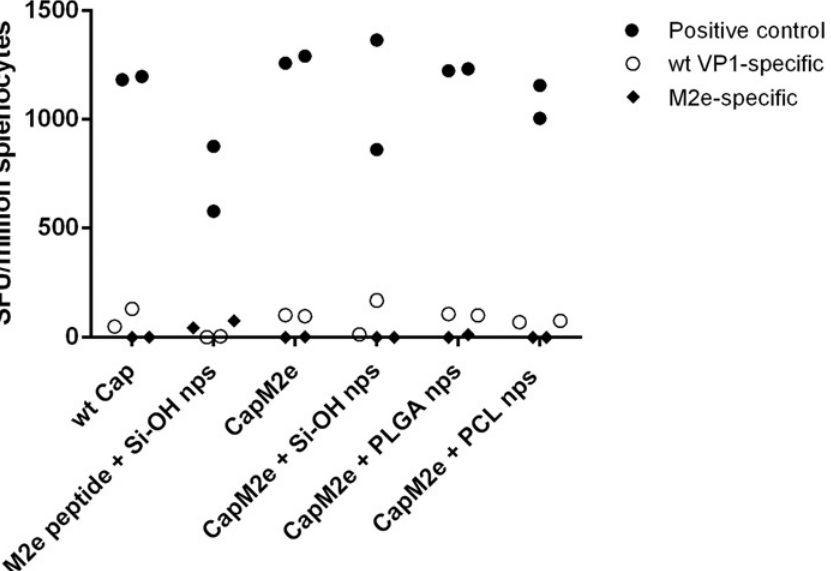
Fig 4. Determination of IFN γ response in splenocytes. M2e-specific T-cell response was evaluated by measuring IFN γ secreting cells by enzyme-linked immunospot (ELISPOT). A) Carrier (wt VP1)-specific, B) M2e-specific, C) positive control (Concanavalin A (Con A)). No significant difference was observed between the mean value of each group (p >